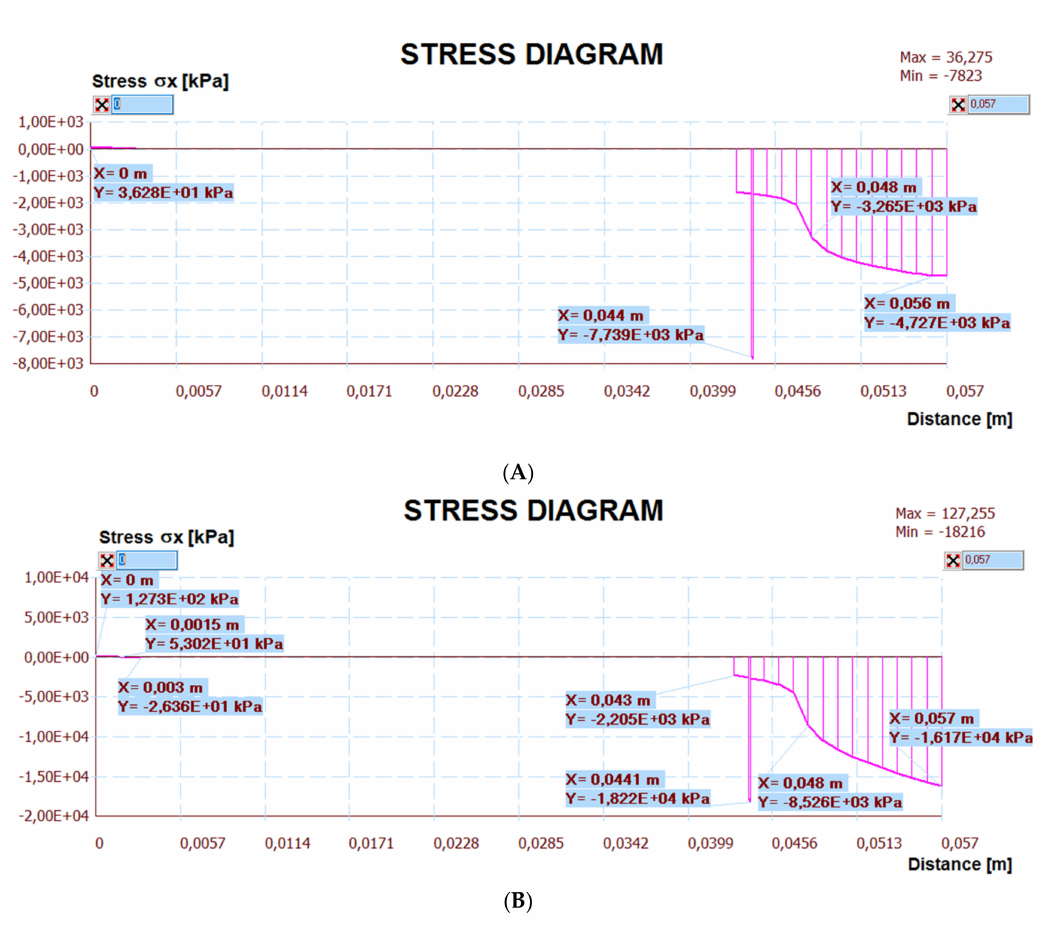
Figure 31. Diagram of horizontal stresses σ x in the I–I section: ( A ) thermal action without ceiling deflection; ( B ) thermal action and imposed load with ceiling